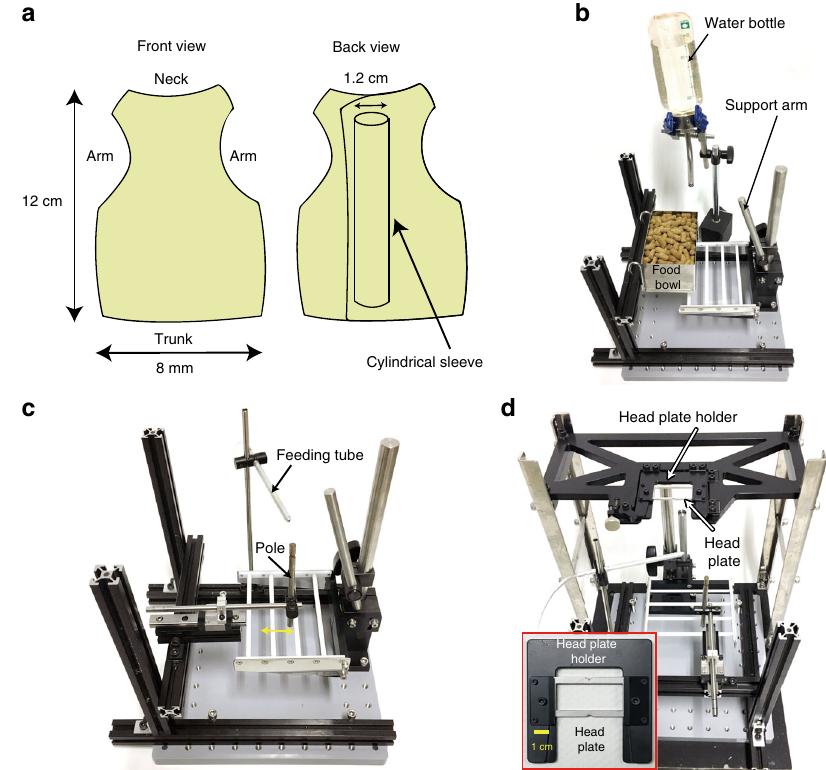
Fig. 1 Design of the task apparatus. a Layout of the jacket modi fi ed from Schultz-Darken et al. 27 . The jacket has openings for the neck, arms, and trunk to pass through. The girth of the trunk was adjusted with a hook-and-loop fastener. The illustrations of the back view show the cylindrical sleeve used to restrain the trunk. b Apparatus for habituation to trunk constraint. The support arm was inserted through the cylindrical sleeve and restrained the trunk of the marmoset. The support arm and the cylindrical sleeve were fi xed by a clip. The marmoset grasped the white scaffolding with leg paws, ate food pellets from the food bowl with upper limbs, and drank drops from the water bottle. c Apparatus for the self-initiated pole-pull task. The yellow double-headed arrow indicates the range in which the pole could move (3.5 cm). d A head plate was clamped by a head plate holder (inset), and the head plate holder was clamped by the